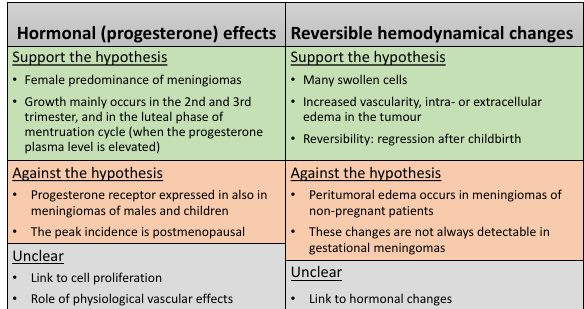
Hormonal (progesterone) effects